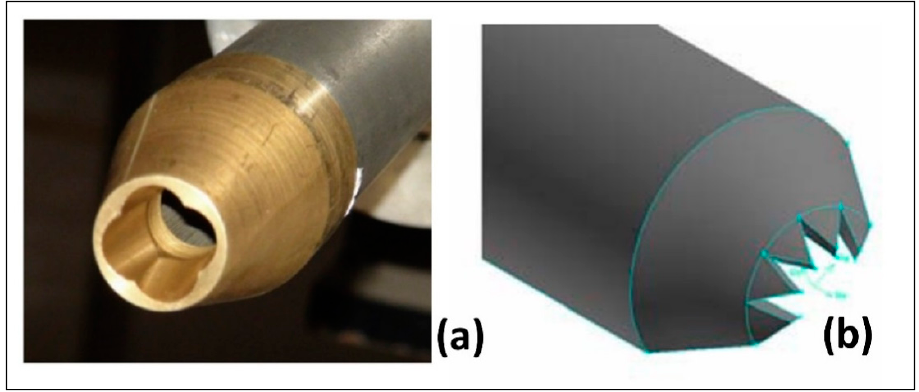
Figure 7. Other primary nozzles variants: (a) lobed nozzle [33]; (b) nozzle with chevrons [34] .